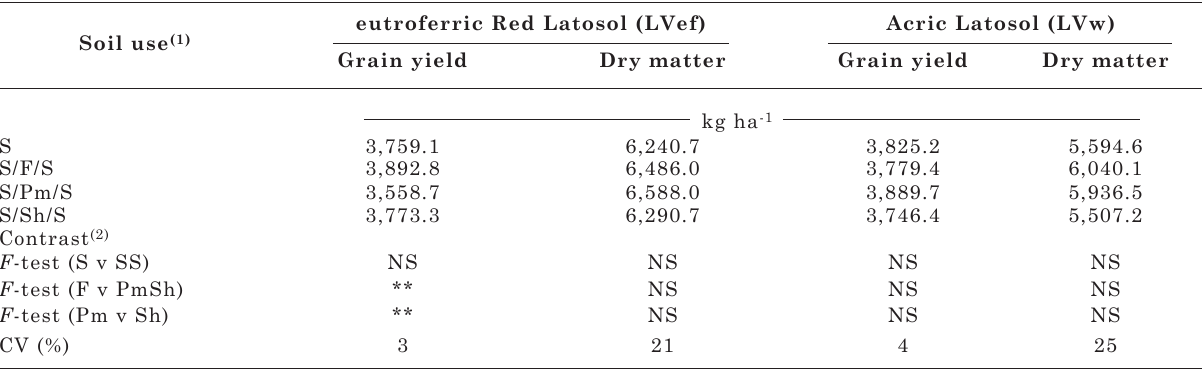
table 5. Soybean yield and residue dry matter amount after the grain harvest in march 2010 and signi- ficance of the contrasts